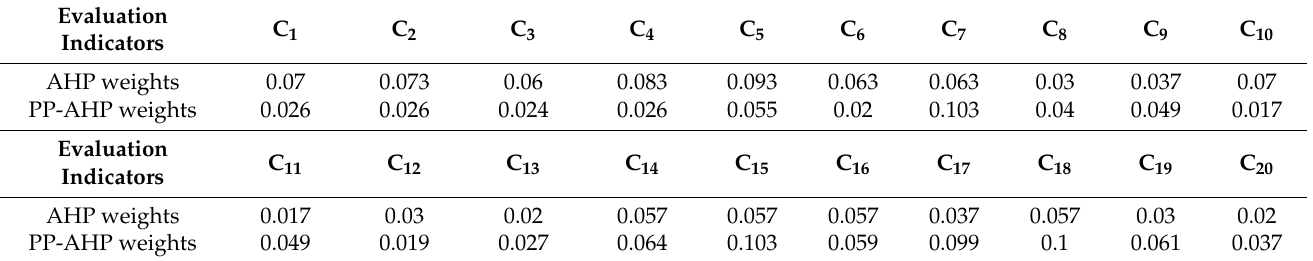
Table 3. Weights of evaluation indicators for water environment carrying capacity in Harbin.